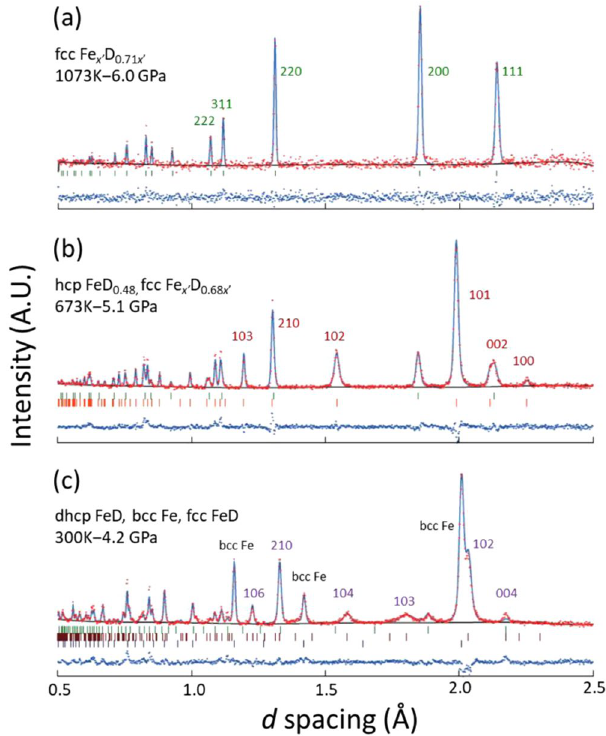
Figure 3. Experimental and simulated neutron diffraction profiles of iron deuteride at ( a )1073 K and 6.0 GPa, ( b ) 673 K and 5.1 GPa, and ( c ) 300 K and 4.2 GPa: blue lines indicate differences between the experimental (red dots) and simulated (blue curves) profiles; reflection indices are assigned to the major peaks of the dominant structures ( a ) fcc, ( b ) hcp, and ( c ) dhcp; tick marks indicate the positions of allowed Bragg peaks for each